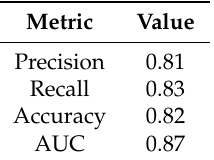
Figure 7. ML Training Results: ( a ) Training accuracy for all model iteration. ( b ) Accuracy of the top five iterated models sorted by the training accuracy. ( c ) ROC curve of the voting ensemble classifier. ( d ) Confusion matrix showing the four scenarios of classification for the voting ensemble model. Table 4. Voting Ensemble Training